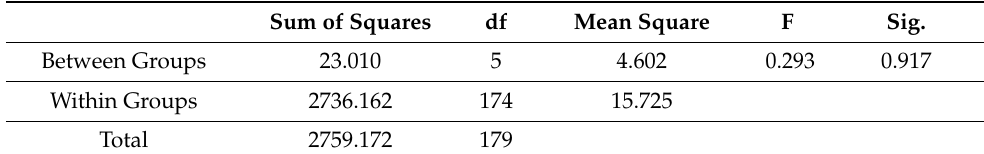
Table 14. One-way ANOVA test on the 500-PHEV